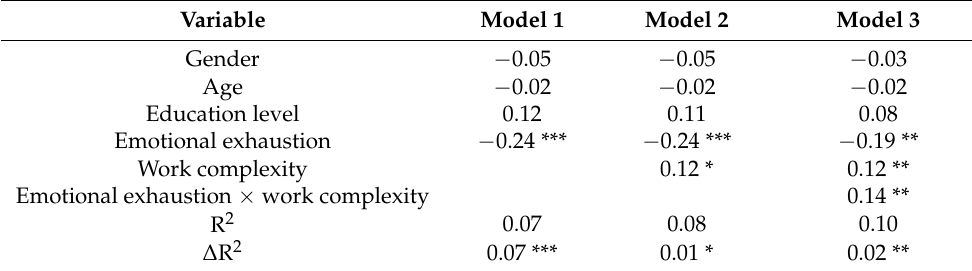
Table 6. Hierarchical regression